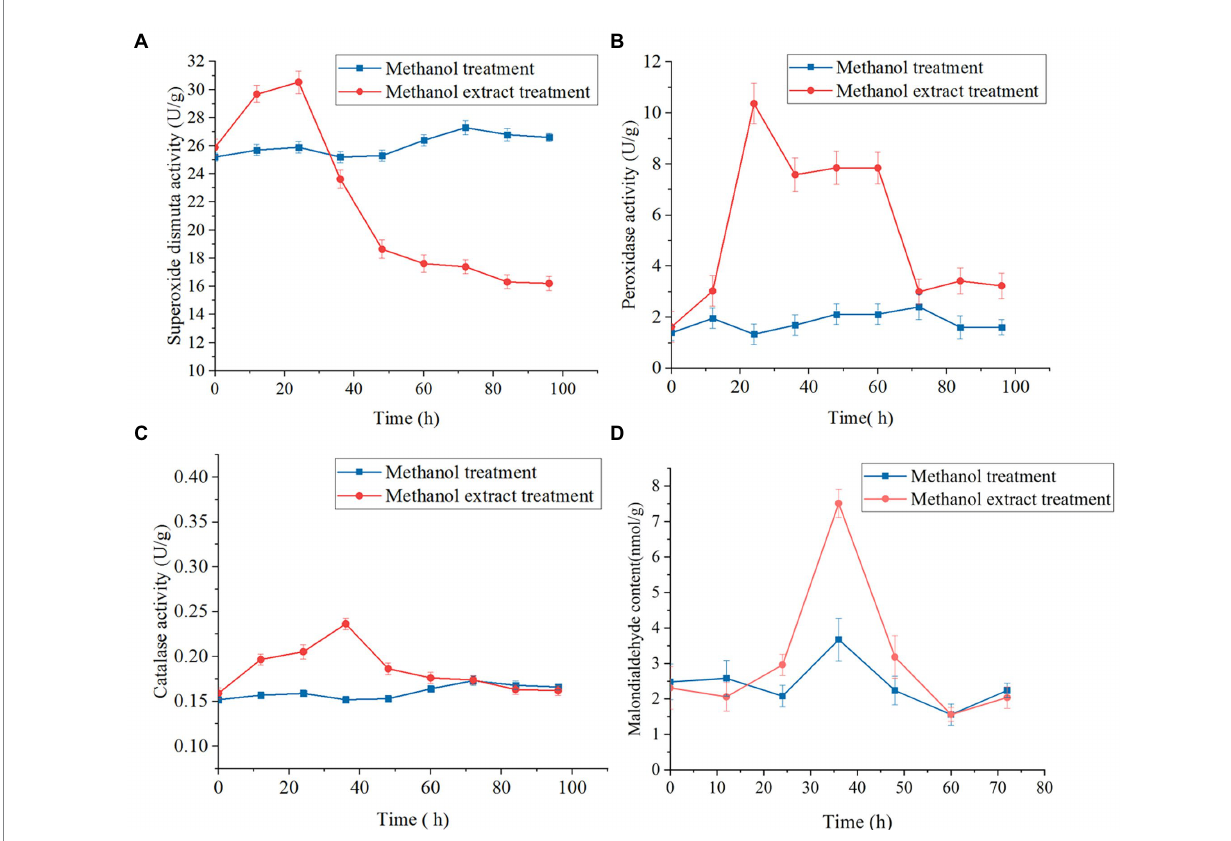
FIGURE 8 Effects of methanol extract (100 μ g/ml) on SOD (A) , POD (B) and CAT (C) activity and MDA content (D) in Fusarium graminearum . The hyphal cells of F. graminearum with or without treatment with methanol extract (100 μ g/ml) are shown. Methanol (0.04% [vol/vol]) served as the control treatment. The error bars in the figures indicate the standard deviations (±SD) from three independent